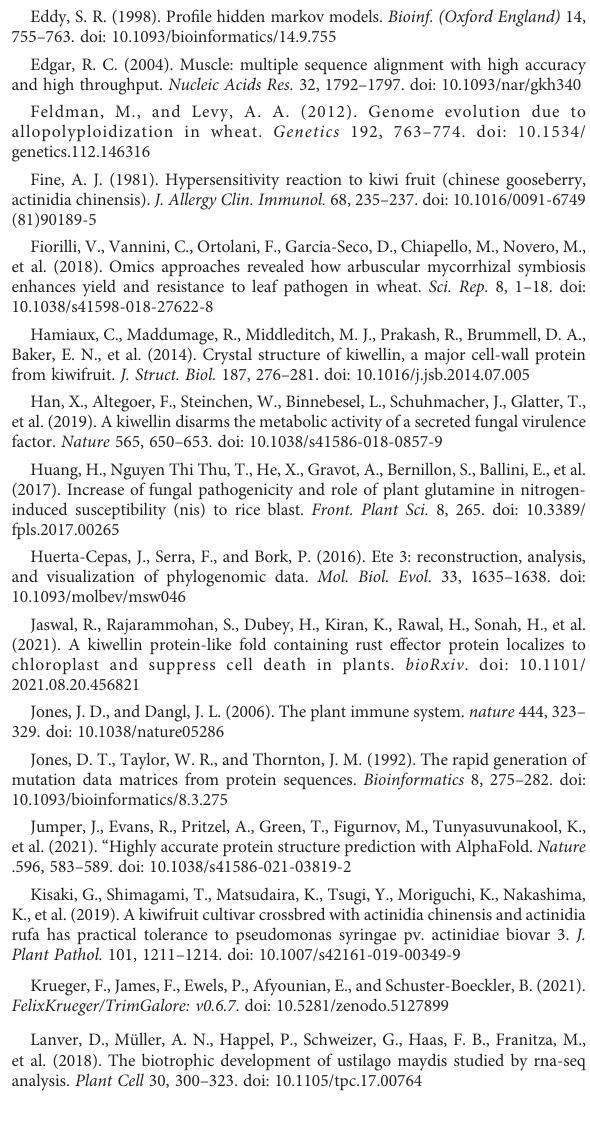
SUPPLEMENTARY DATA SHEET 2 Fully reconciled Kiwellin evolution